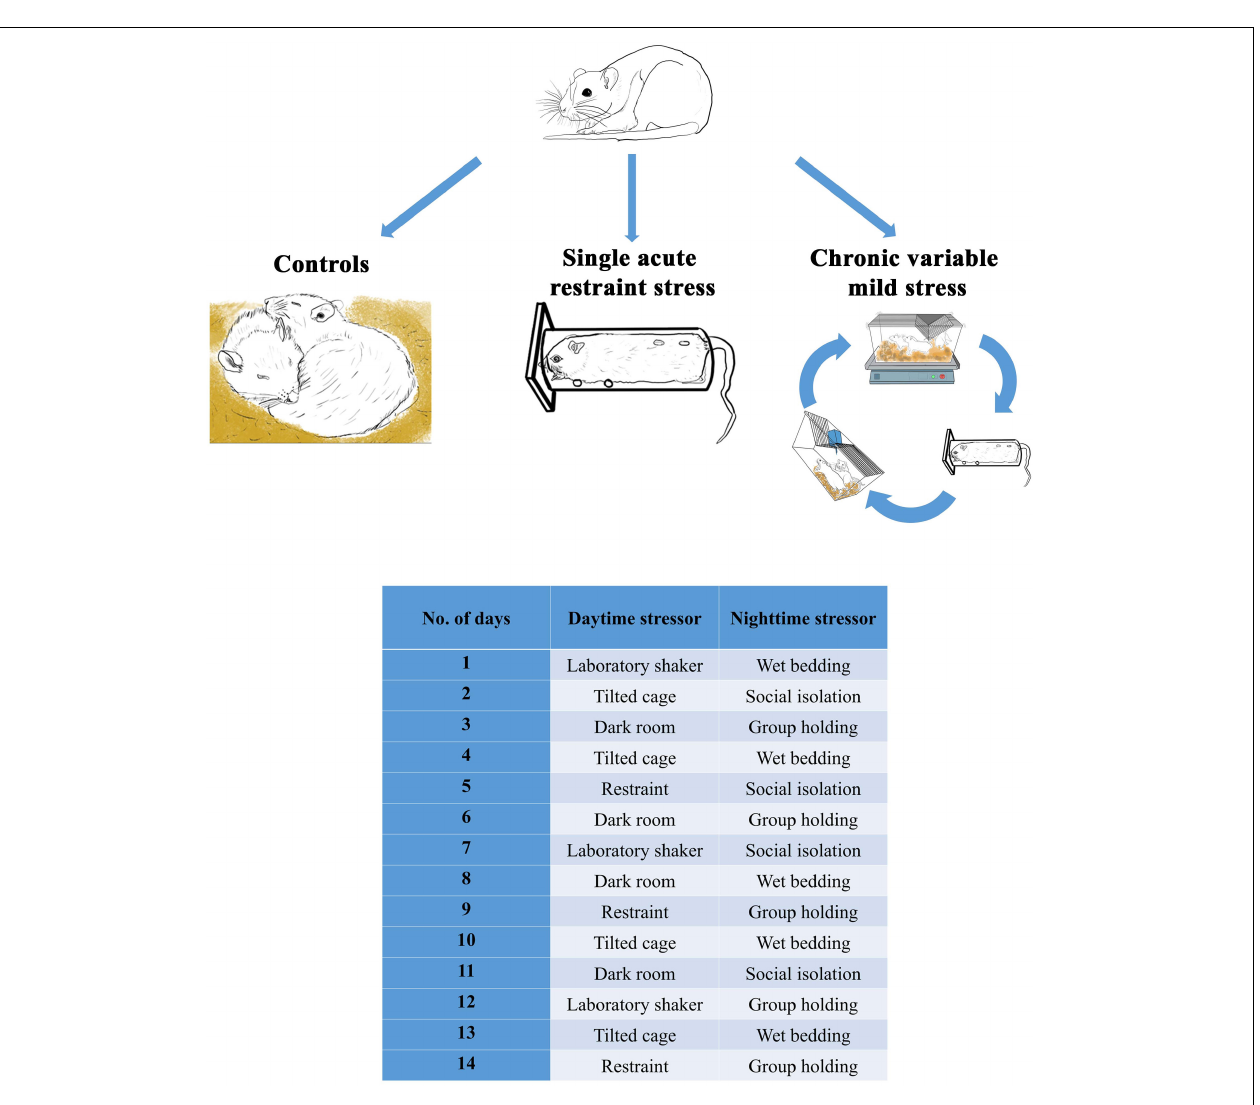
FIGURE 1 | Experimental design and the 2-weeks-long chronic variable mild stress